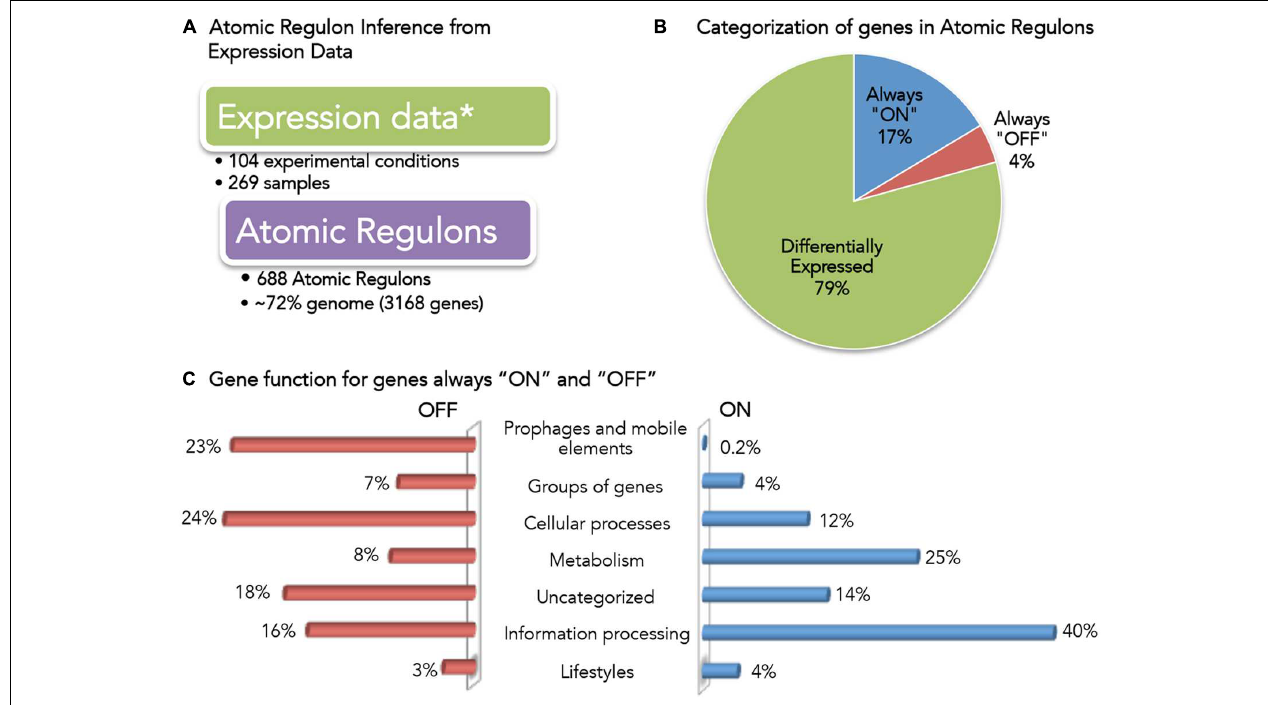
FIGURE 3 | Overview of Bacillus subtilis Atomic Regulons (ARs). (A) Expression data used for AR inference in B. subtilis (Buescher et al., 2012; Nicolas et al., 2012). (B) Categorization of genes in ARs. Genes have been categorized based on the expression profile as always “ON”, always “OFF” and differentially expressed. (C) Gene function for genes always “ON” and “OFF”. B. subtilis 168 genes are classified in SubtiWiki (Florez et al., 2009; Mader et al., 2012) into 6 categories cellular function; here we show the fraction of genes in the “always ON” regulon (right) and the “always OFF” regulon (left) that occur in each